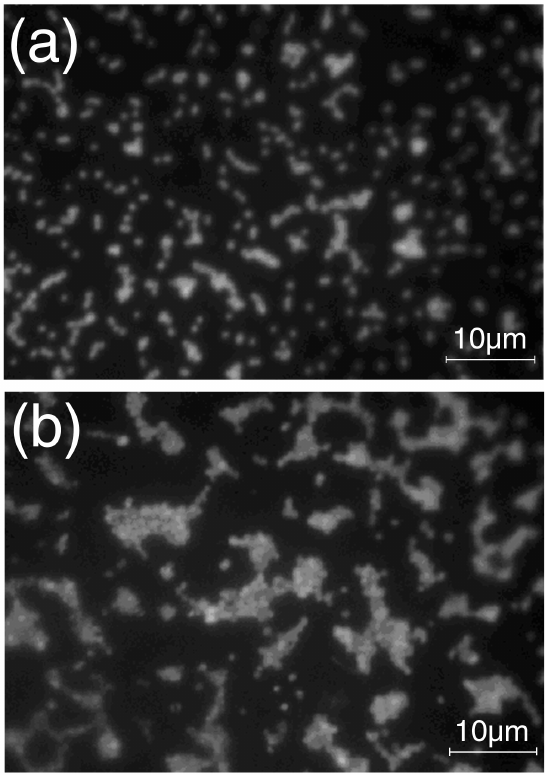
Figure 2. Micrographs of acridine orange stained cells of Pyrococcus furiosus and P. woesei growing in sulfur-free medium containing 1% maltoseand 100 µM sodium tungstate. The photographs were taken at identical magnification with an oil immersion objective lens. Num- bers in parentheses are the volumes of the cultures used to prepare the microscopic slides. (a) Pyrococcus furiosus at 19 h. The cell density corresponds to the value shown in Figure 1 (about 3 × 10 7 cells ml –1 ). Most cells were single, in pairs or in short chains and rarely in aggre- gated morphologies. (b) Pyrococcus woesei at 19 h. The cell density of the value for the mid-exponential growth phase shown in Figure 1 (about 1.6 × 10 6 cells ml –1